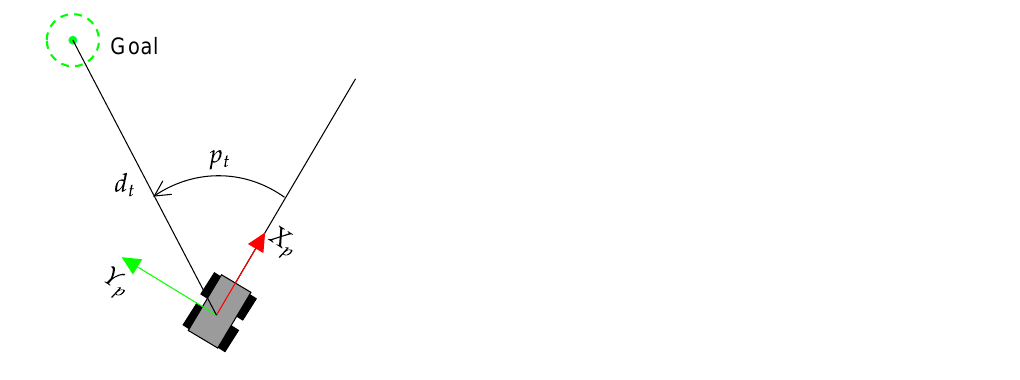
Figure 7. Heading error p t and distance d t of Andabata with respect to the target at the discrete time step t .